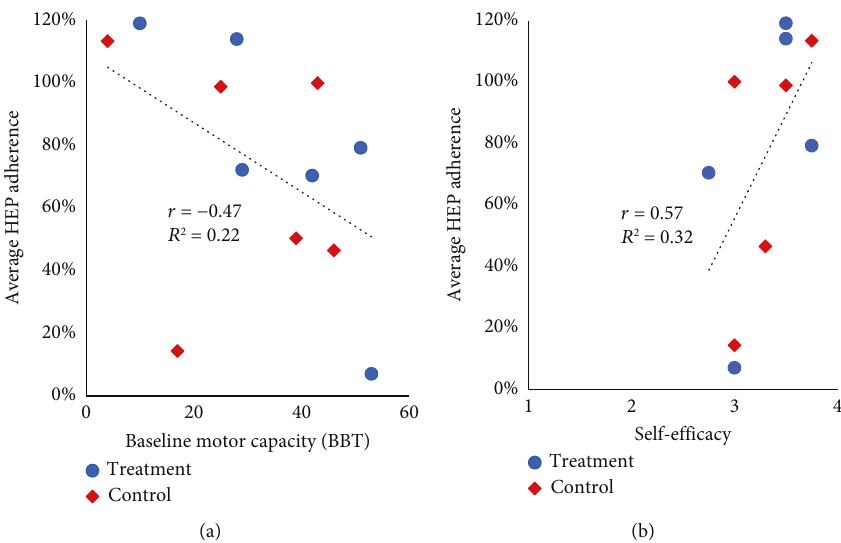
Figure 4: Relationship between baseline motor capacity measured by the Box and Block Test (BBT) score and the average percent HEP adherence (a). Relationship between self-e ffi cacy and average percent HEP adherence (b). The treatment group participants are represented by blue circles and control group participants are represented by orange